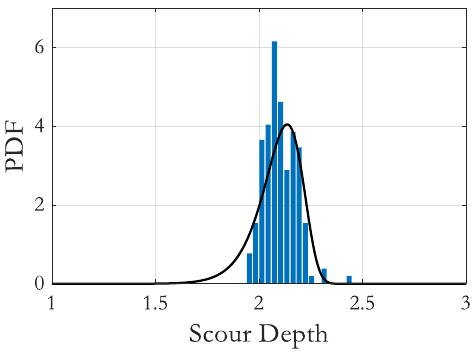
Figure 12. Probability distribution of SD.